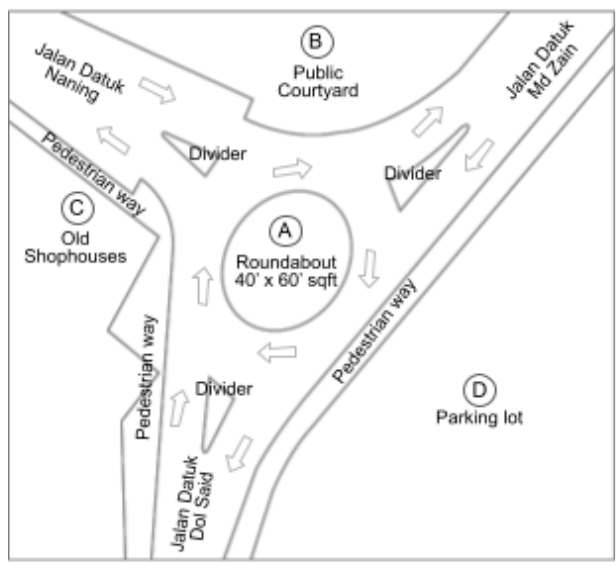
Figure 2. Alor Gajah town roundabout.